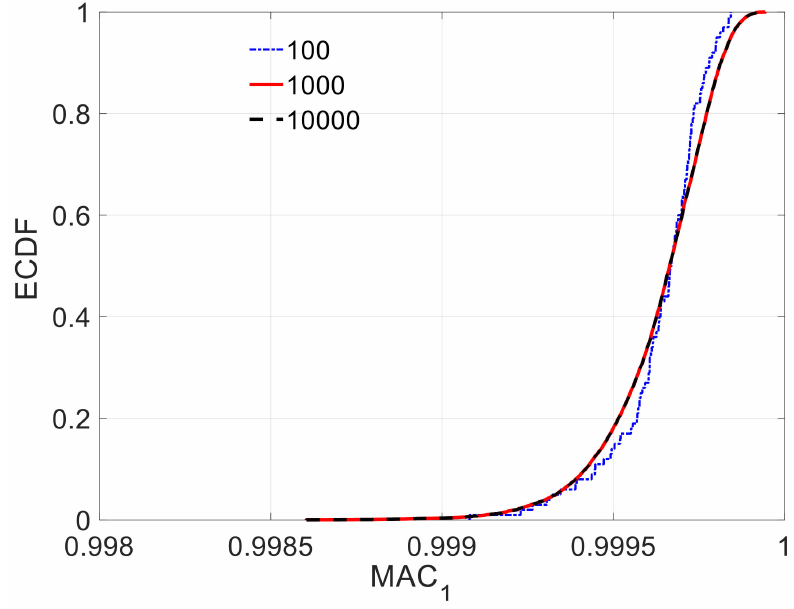
Figure 13. ECDF of MAC 1 under different sample sizes.